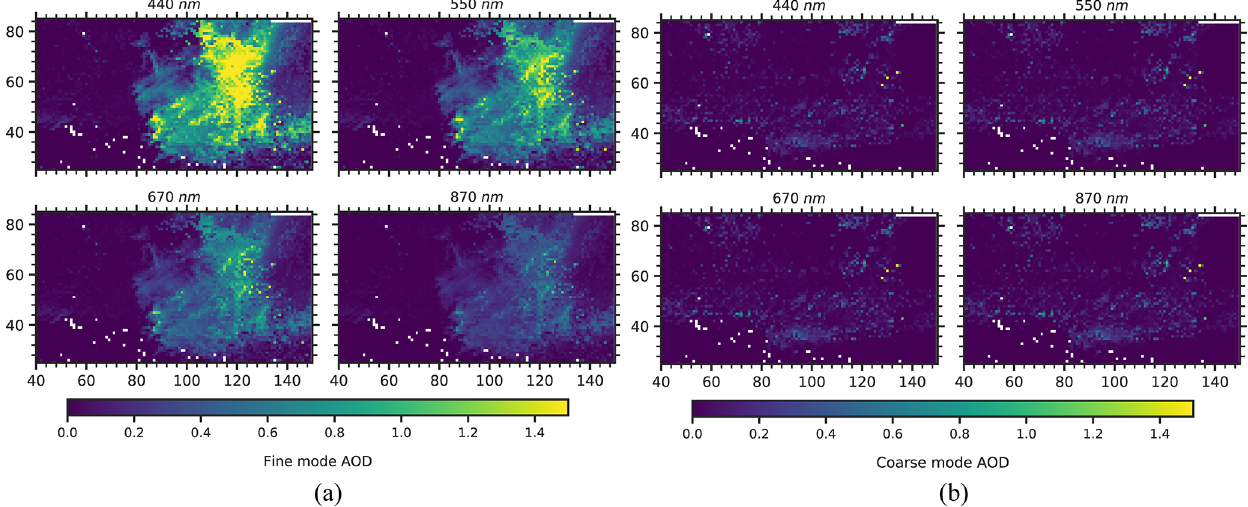
Figure 10. (a) Fine-mode AOD map of a subsetted portion of the 27 October 2017 T18:16UTC smoke scene that was marked by a red rectangular box in Fig. 8 for all AirHARP spectral bands; (b) same as (a) but for coarse-mode AOD. X and Y axes are the pixel